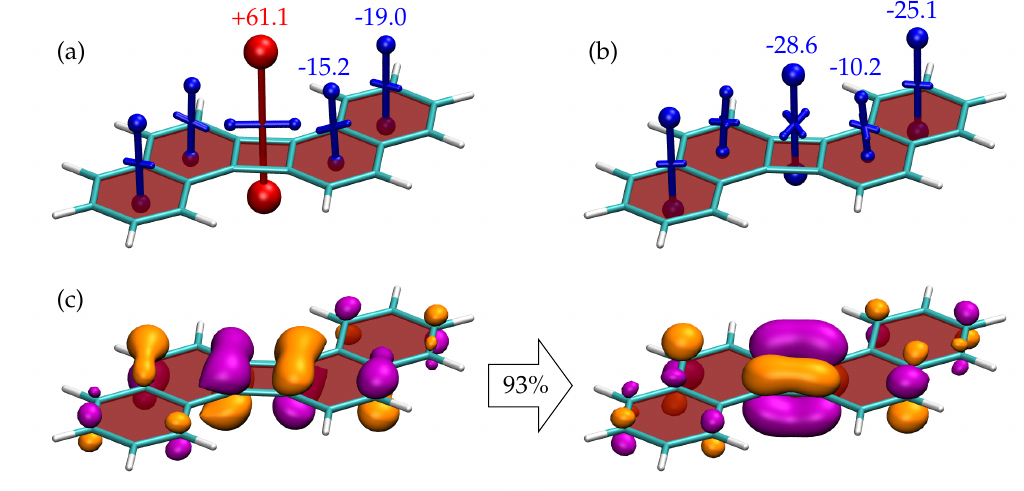
Figure 7. Visualisation of chemical shielding tensors (VIST) for ( a ) the S 0 and ( b ) the T 1 states of 4 computed 1 Å above the molecular plane. The dominant pair of natural transition orbitals (isovalue 0.05 a.u., weight 93 %) for the S 0 → T 1 transition is shown in ( c